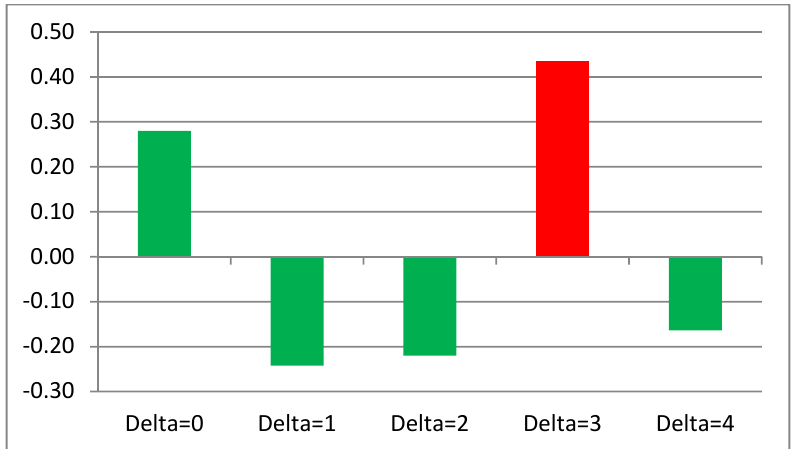
Figure 21. Linear Correlation between the Highest Epidemic Intensity in TWC Beta and TWC Gamma Scalar Fields, With Different Temporal